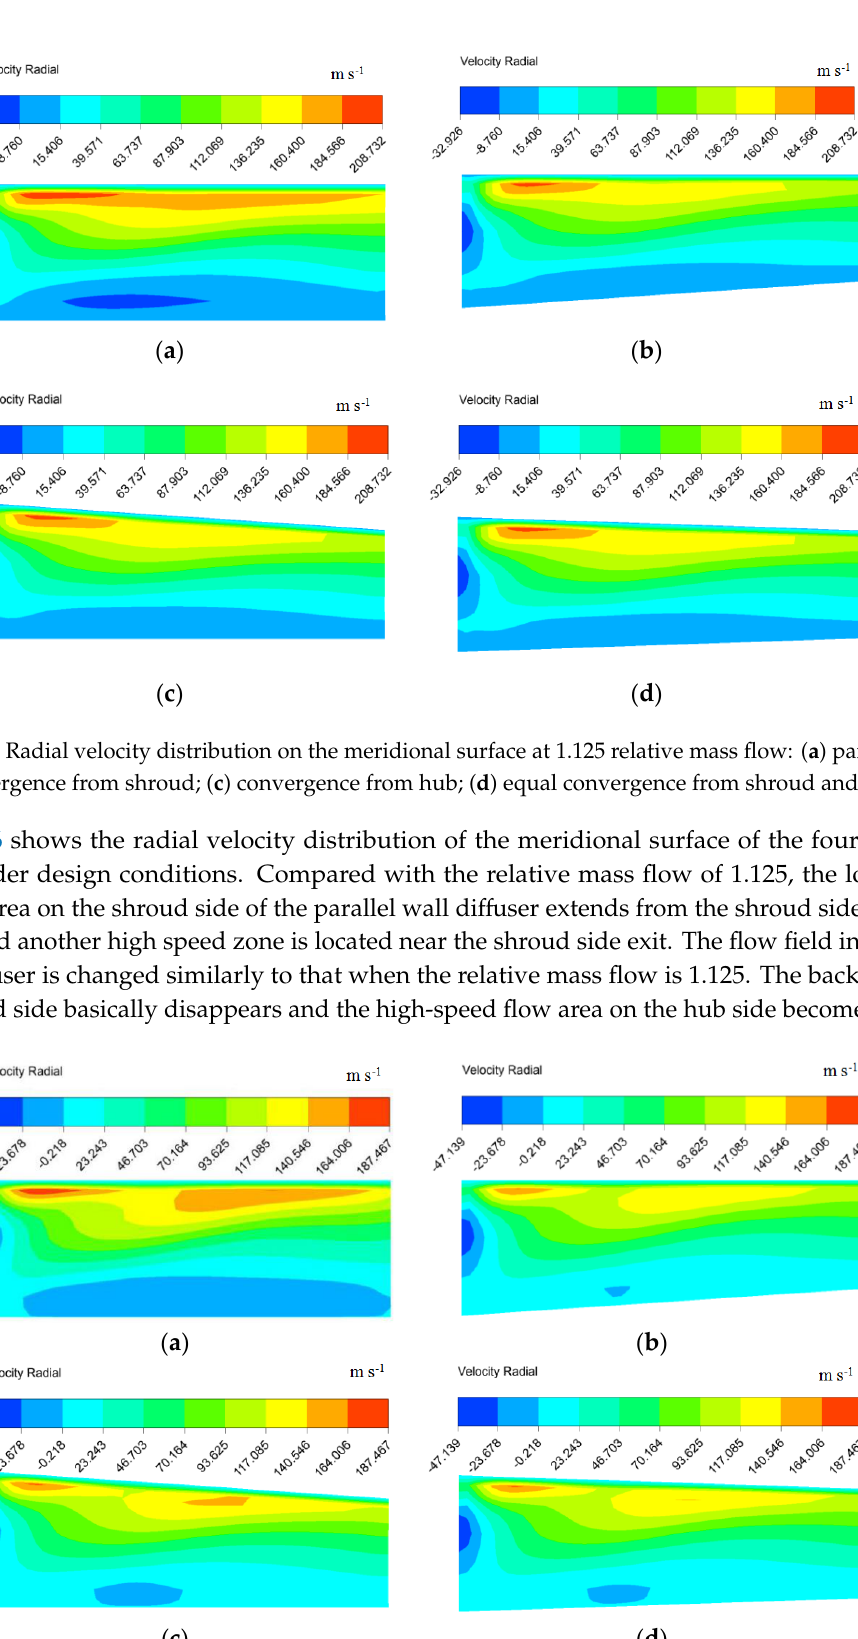
Figure 6. Radial velocity distribution on the meridional surface at 1 relative mass flow: ( a ) parallel; ( b ) convergence from shroud; ( c ) convergence from hub; ( d ) equal convergence from shroud and hub.